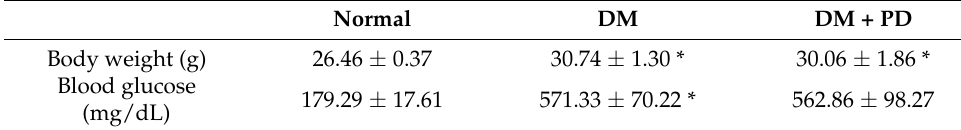
Table 1. Body weight and blood glucose.